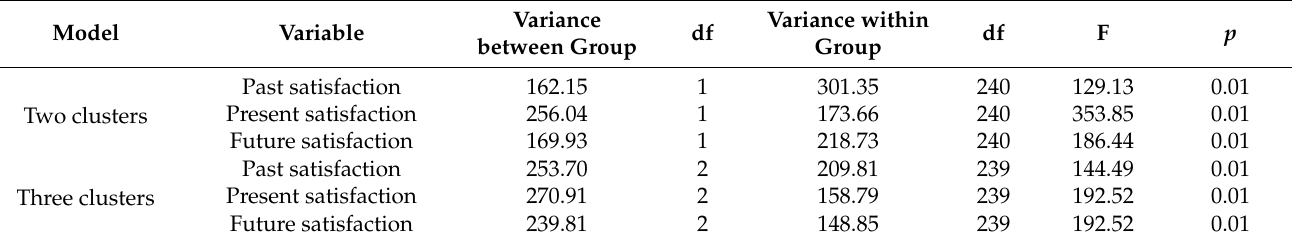
Table 4. Variance within and between groups for the Temporal Satisfaction with Life Scale : results of k-means clustering analysis.